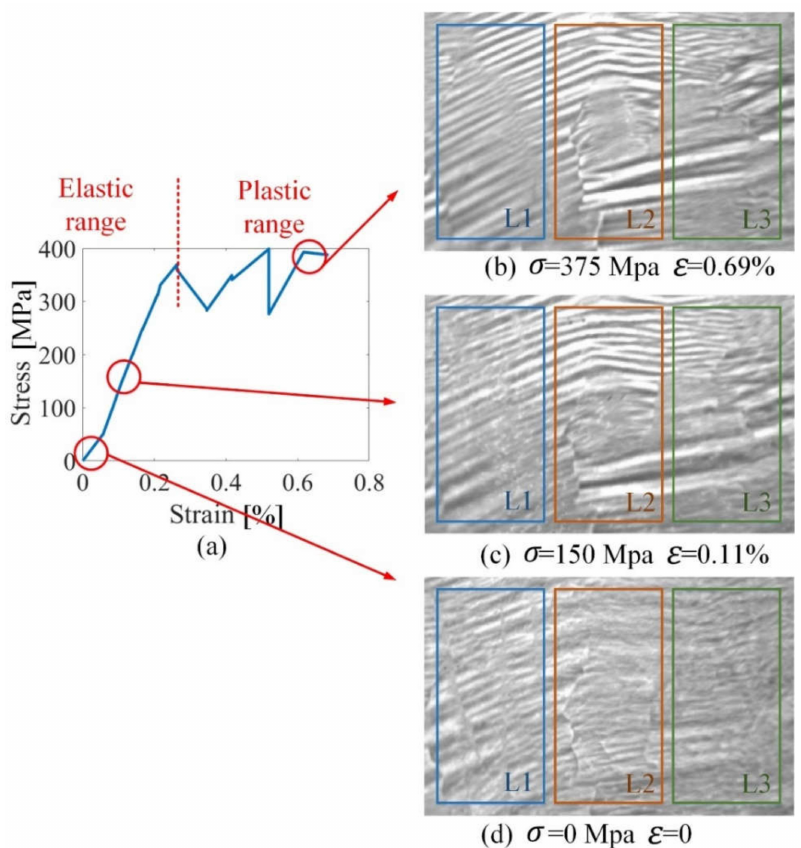
Figure 8. Grain, GB and DW distribution of sample 2 under stress in the elastic and plastic range. ( a ) illustrates the stress–strain curve of silicon steel sheet sample 2; ( b – d ) illustrate the DW distribution and GB migration of sample 2 under stress. (Note: L1, L2, and L3 denote three locations to analyze the effect of grain and GB microstructure on MBN transient eigenvalues ( T σ and INT σ ). The sizes of ( b – d ) are 6.5 mm × 11.5